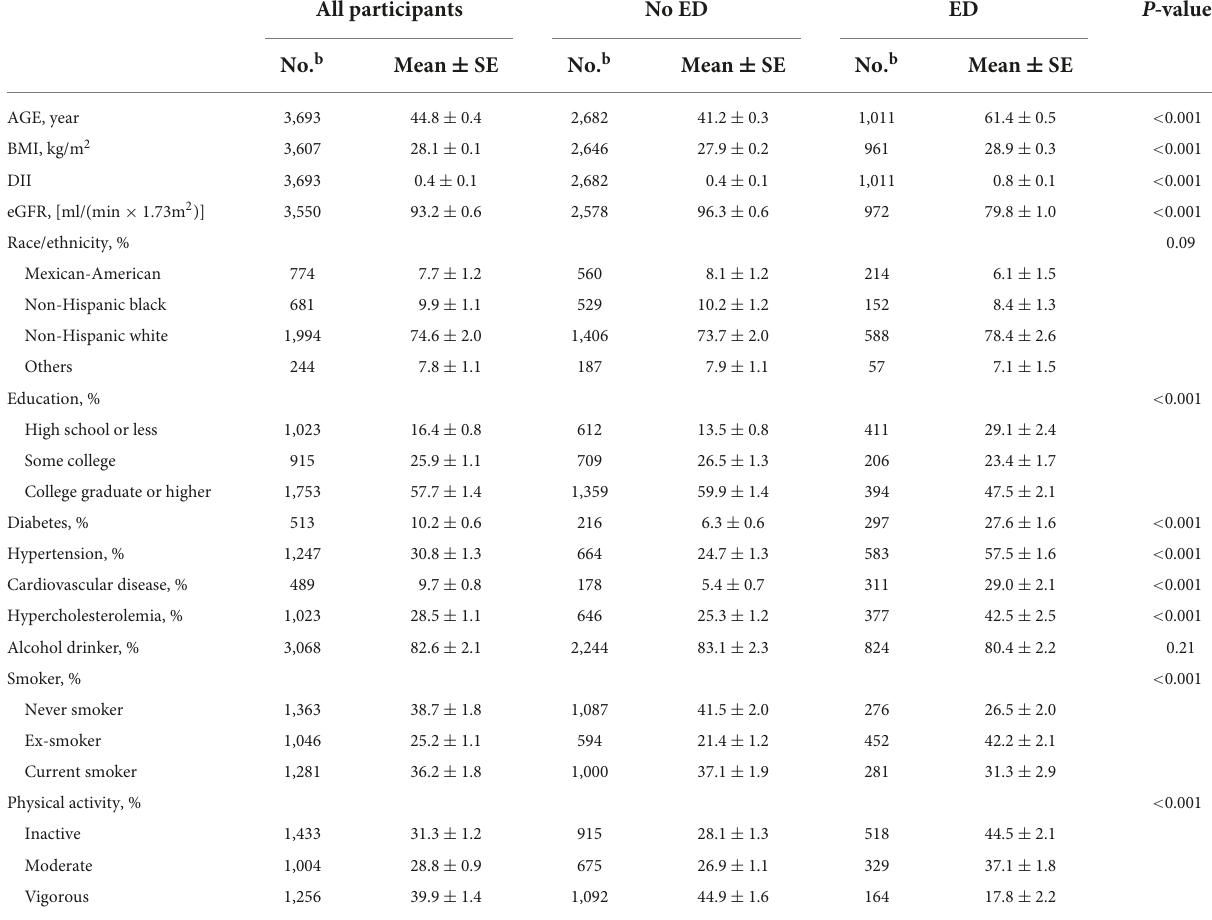
TABLE 1 Weighted distributions of characteristics of participants.